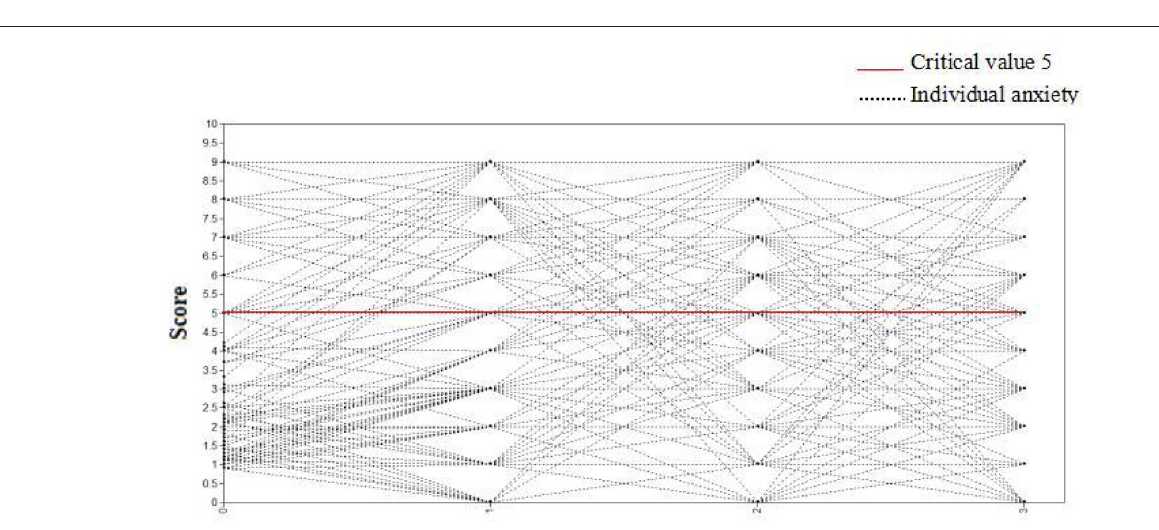
FIGURE 7 | The changing trajectory of anxiety of medical staff after